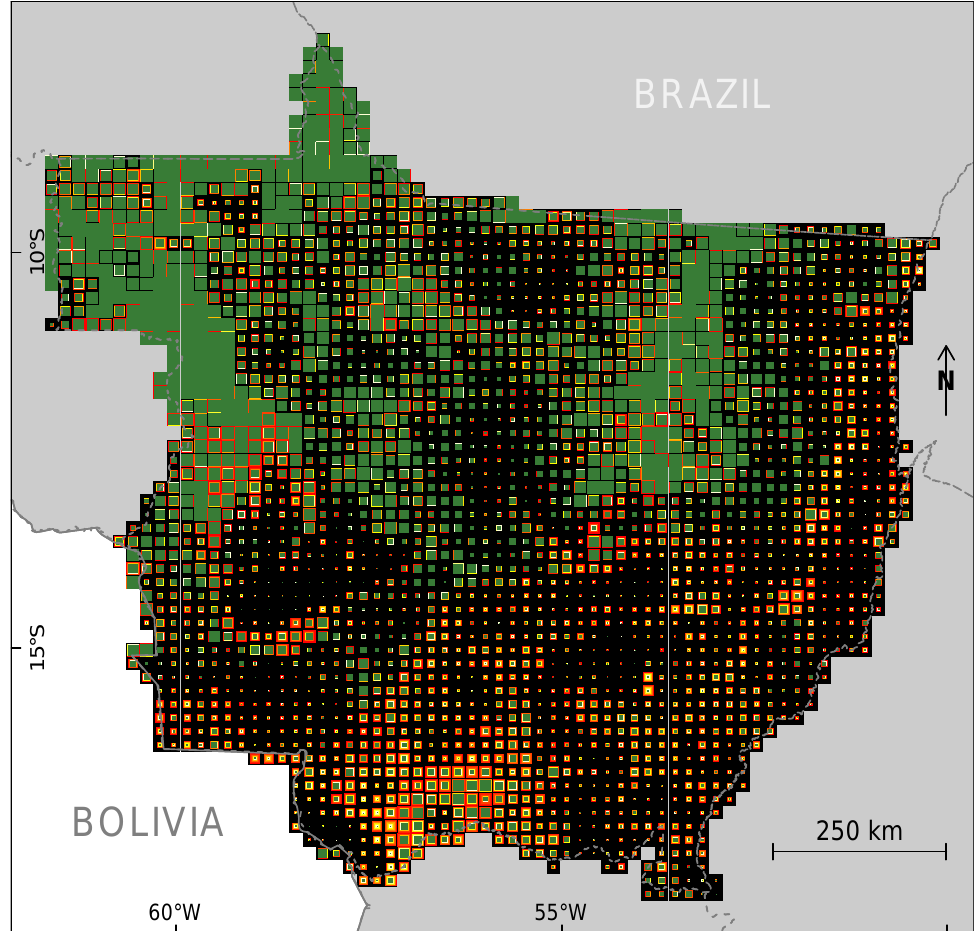
Figure 4. Tree cover and tree cover loss per year for the 2658 planet tiles covering the Mato Grosso state, Brazil, with colored areas representing the real size of tree cover, deforestation, and non-tree cover in each tile. Remaining tree cover of 2015 is in green, and the yellow-to-red color scale represents the deforestation, with red being the more